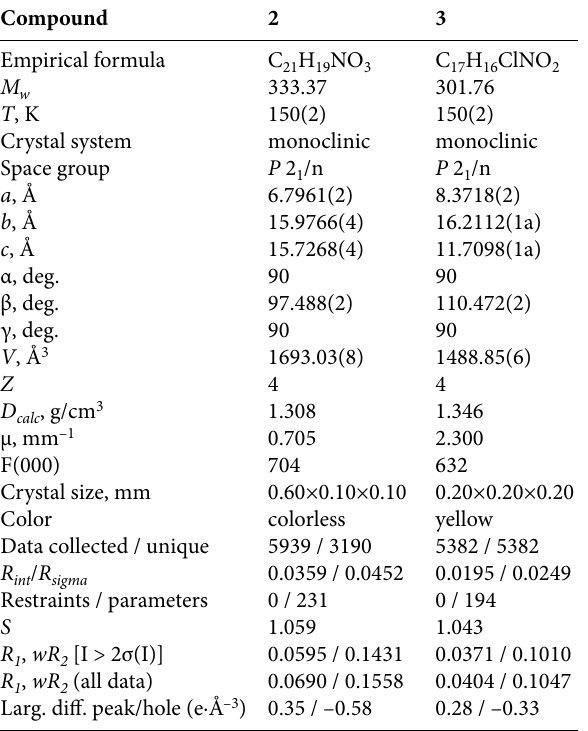
Table 1 . Crystal data and structure refinement summary of com- pounds 2 and